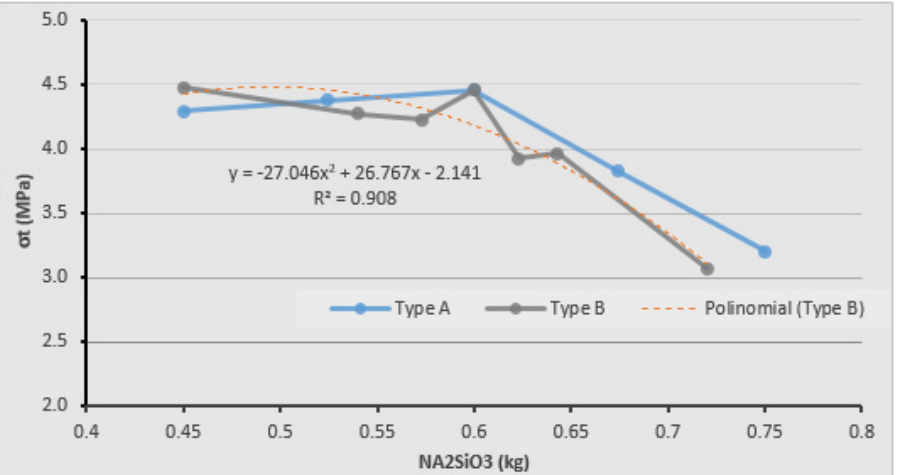
Figure 7. Influence of sodium hydroxide (NaOH) on the tensile strength.